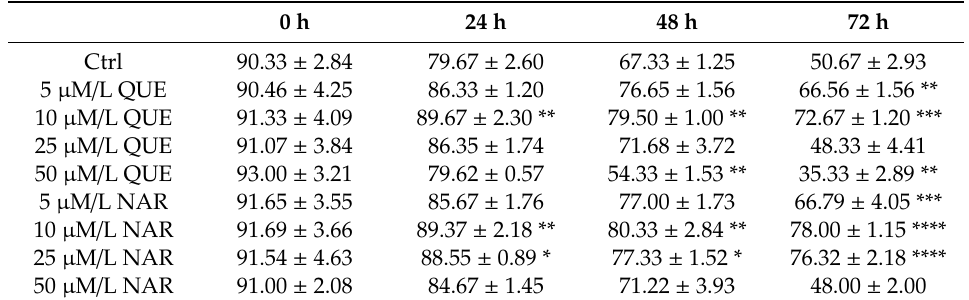
Table 2. Membrane integrity (%) of extended boar spermatozoa following exposure to quercetin or naringenin ( n = 28).